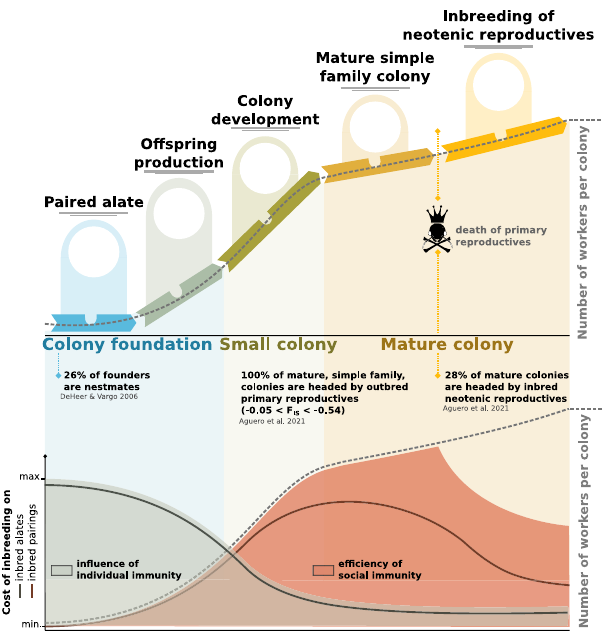
Fig. 6 Schematic illustration of the cost of inbreeding termite colonies face over the different stages of their lifespan. The dotted lines represent colony size (i.e., the number of workers per colony). The red line represents the cost of inbreeding depression on inbred pairings. Inbreeding depression is low during colony foundation and offspring production, but is higher during colony development, when small colonies face pathogen pressure (this study 29 ). The red area represents the ef fi ciency of social immunity, which increases with colony size until it is expected to slightly decrease due to inbreeding from neotenic reproduction. The gray area represents the in fl uence of individual immunity, which is high in founding couples and in small incipient colonies. The cost of inbreeding in inbred alates (gray line) is high before incipient colonies become large enough to bene fi t from social immunity. The high ef fi ciency of social immunity in large mature colonies releases inbreeding depression, allowing the development of inbred neotenic reproductives without suffering costs associated with pathogen pressure 30